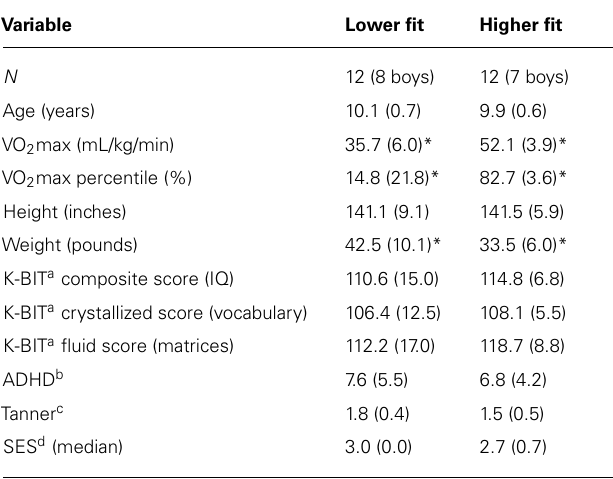
Table 1 | Participant mean demographic and fitness data (SD) by aerobic fitness